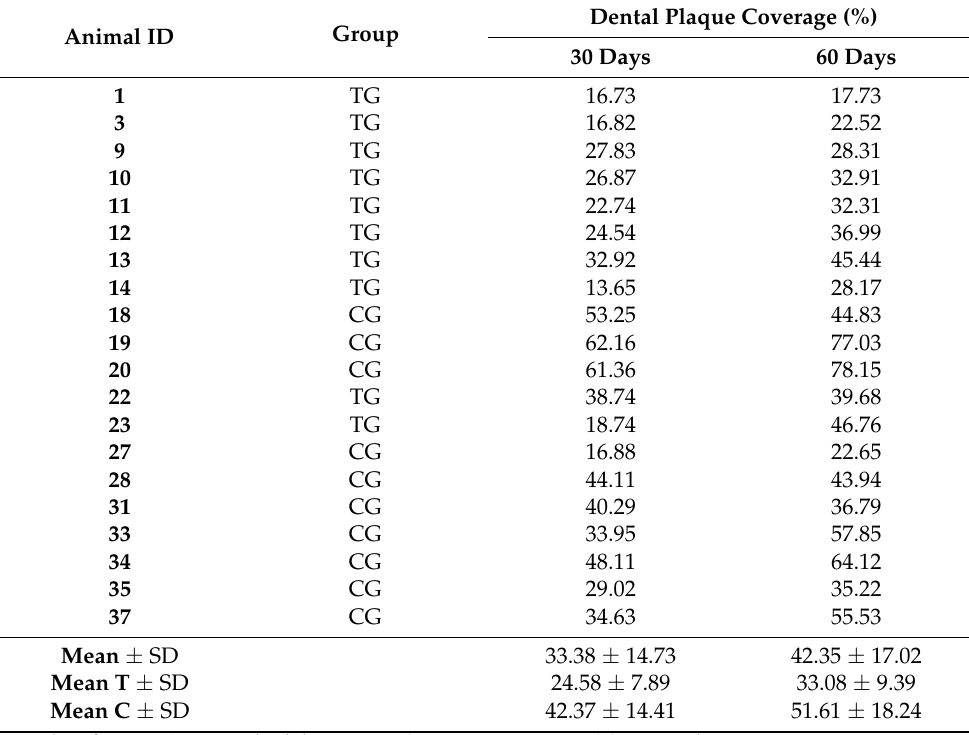
Table 6. Mean dental plaque coverage (%) of each dog, determined after application of a disclosure solution and IMAGEJ analysis, on days 30 and